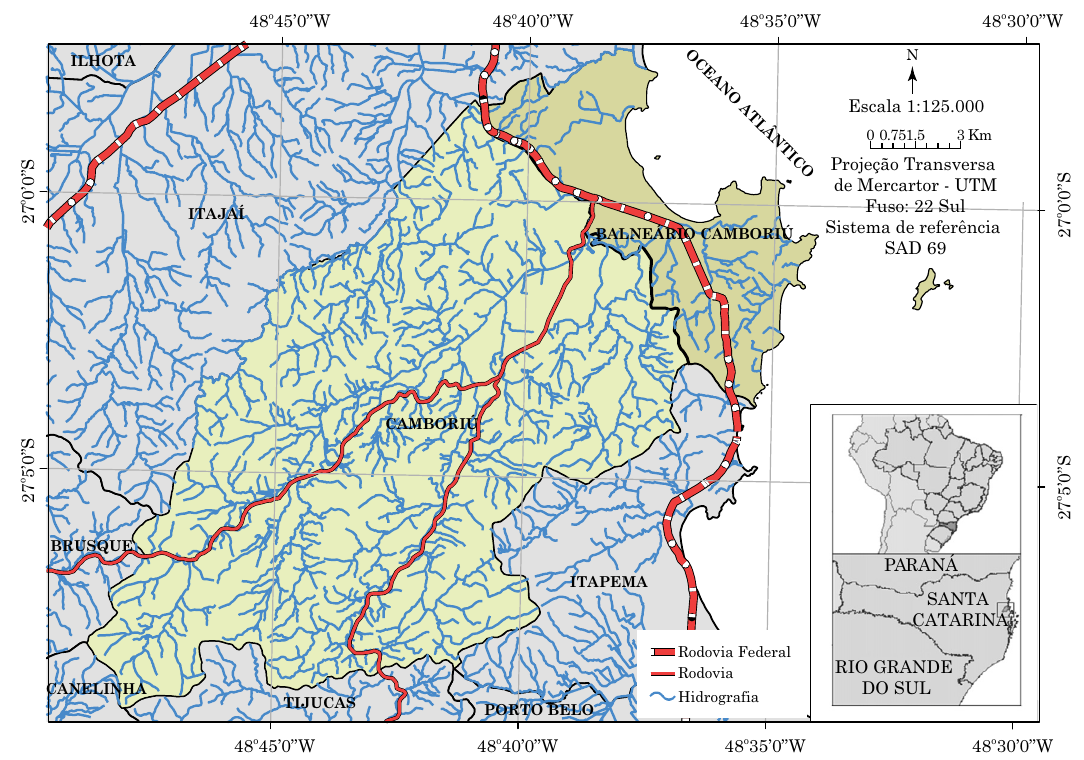
Figura 1. Localização dos municípios de Balneário Camboriú e Camboriú, SC.